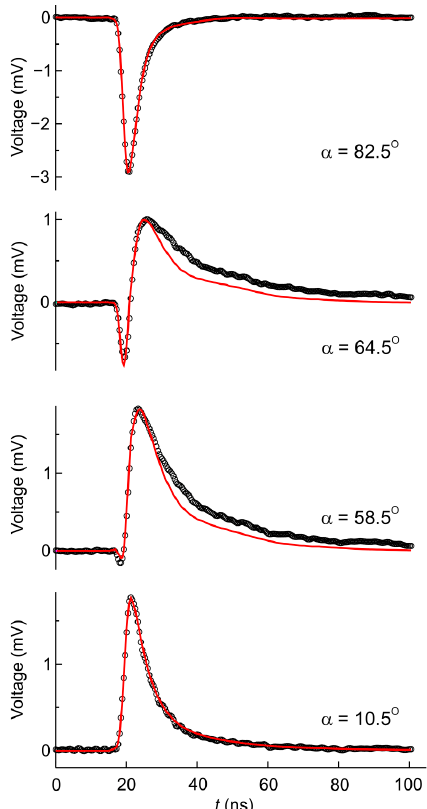
Figure 7. The oscillograms of the photovoltage pulses arising in a thin CuSe/ t -Se film with circular polarization of exciting radiation and angles of incidence α = 10.5, 58.5, 64.5, and 82.5 ° (black cir- cles), and their approximations shown by red lines according to Equation (19).